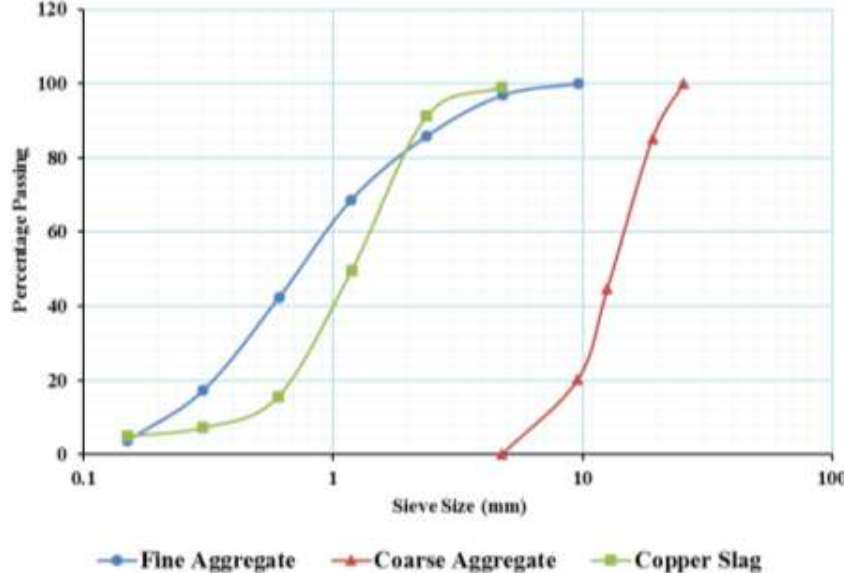
Figure 1. Particle size distribution of fine aggregate, coarse aggregate and copper slag